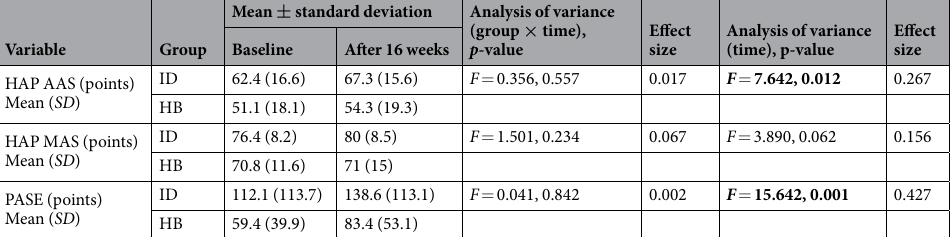
Table 2. Mixed model of repeated measures for patient physical activity levels. HAP: Human Activity Profile questionnaire; MAS: the number assigned to the activity with the highest oxygen consumption requirement on the HAP questionnaire that the patient still performs; ASS: the adjusted activity score is the difference between the MAS and the number of activities with lower scores (less demanding tasks) on the HAP questionnaire that the participant has stopped performing; PASE: Physical Activity Scale for Elderly. Baseline data comparison between ID (n = 11) and HB (n = 12) with the Mann-Whitney test showed no significant differences.